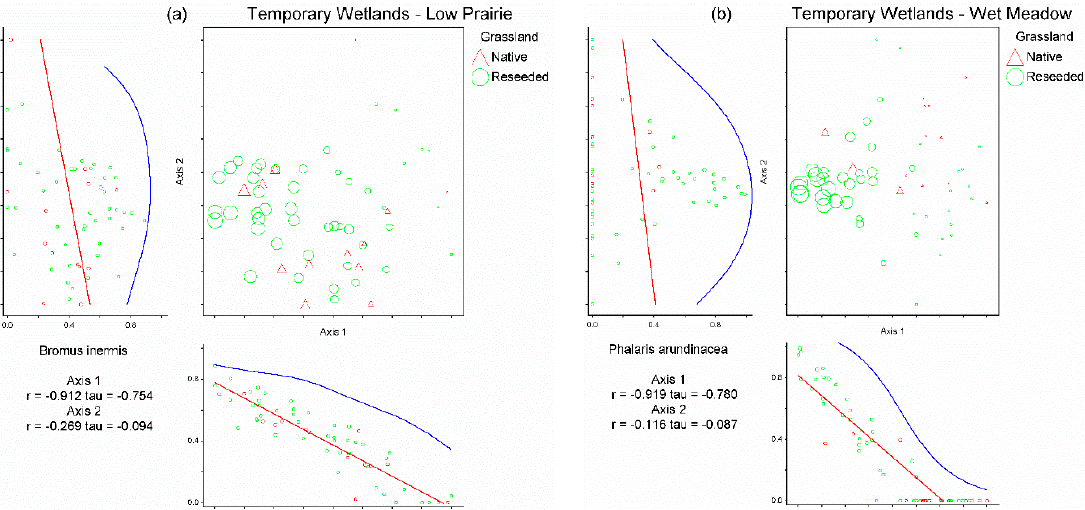
Figure 1. Non-metric multi-dimensional scaling ordinations for the low prairie vegetation zone ( a ) and wet meadow vegetation zone ( b ) of 59 temporary wetlands. Each triangle represents a temporary wetland located on native grassland and each circle represents a temporary wetland located on reseeded grassland. The relative size of site symbols (triangles/circles) indicates the relative cover of Bromus inermis in the low prairie zone ( a ) and Phalaris arundinacea in the wet meadow zone ( b ). Species’ correlations with each axis are included beneath the horizontal axis and to the left of the vertical axis (i.e., B. inermis in the low prairie vegetation zone ( a ); P. arundinacea in the wet meadow vegetation zone ( b )). Table 2. Plant species evaluated as potential drivers of plant community composition of the low prairie and wet meadow vegetation zones of temporary wetlands. Species with Pearson correlation coefficients of r ≥ |0.4| with an NMS axis were selected for further examination as significant drivers. Absolute r values were interpreted to indicate a species’ relative strength as a driver of wetland plant community composition. Emphasis was placed on the first NMS axis because a decreasing amount of variation within the community dataset is explained by each additional axis.